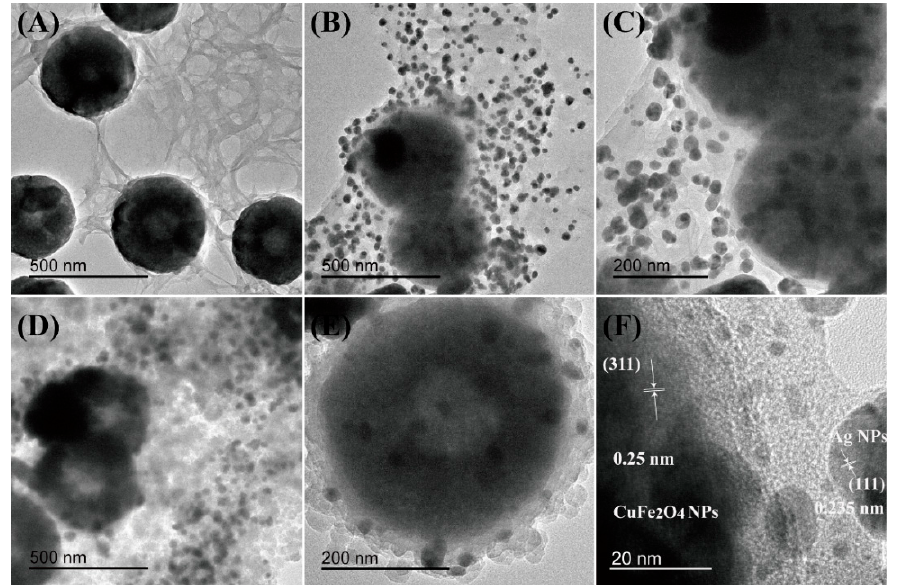
Figure 1. TEM images of the ( A ) CuFe 2 O 4 / CNC nanocomposites; ( B , C ) CuFe 2 O 4 /